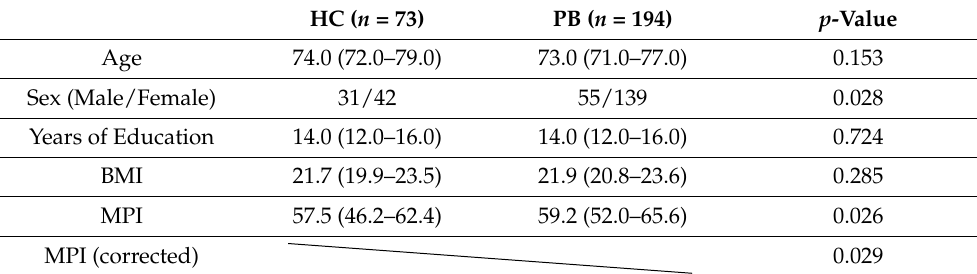
Table 6. Cohort B characteristics classified by the discriminant analysis model.